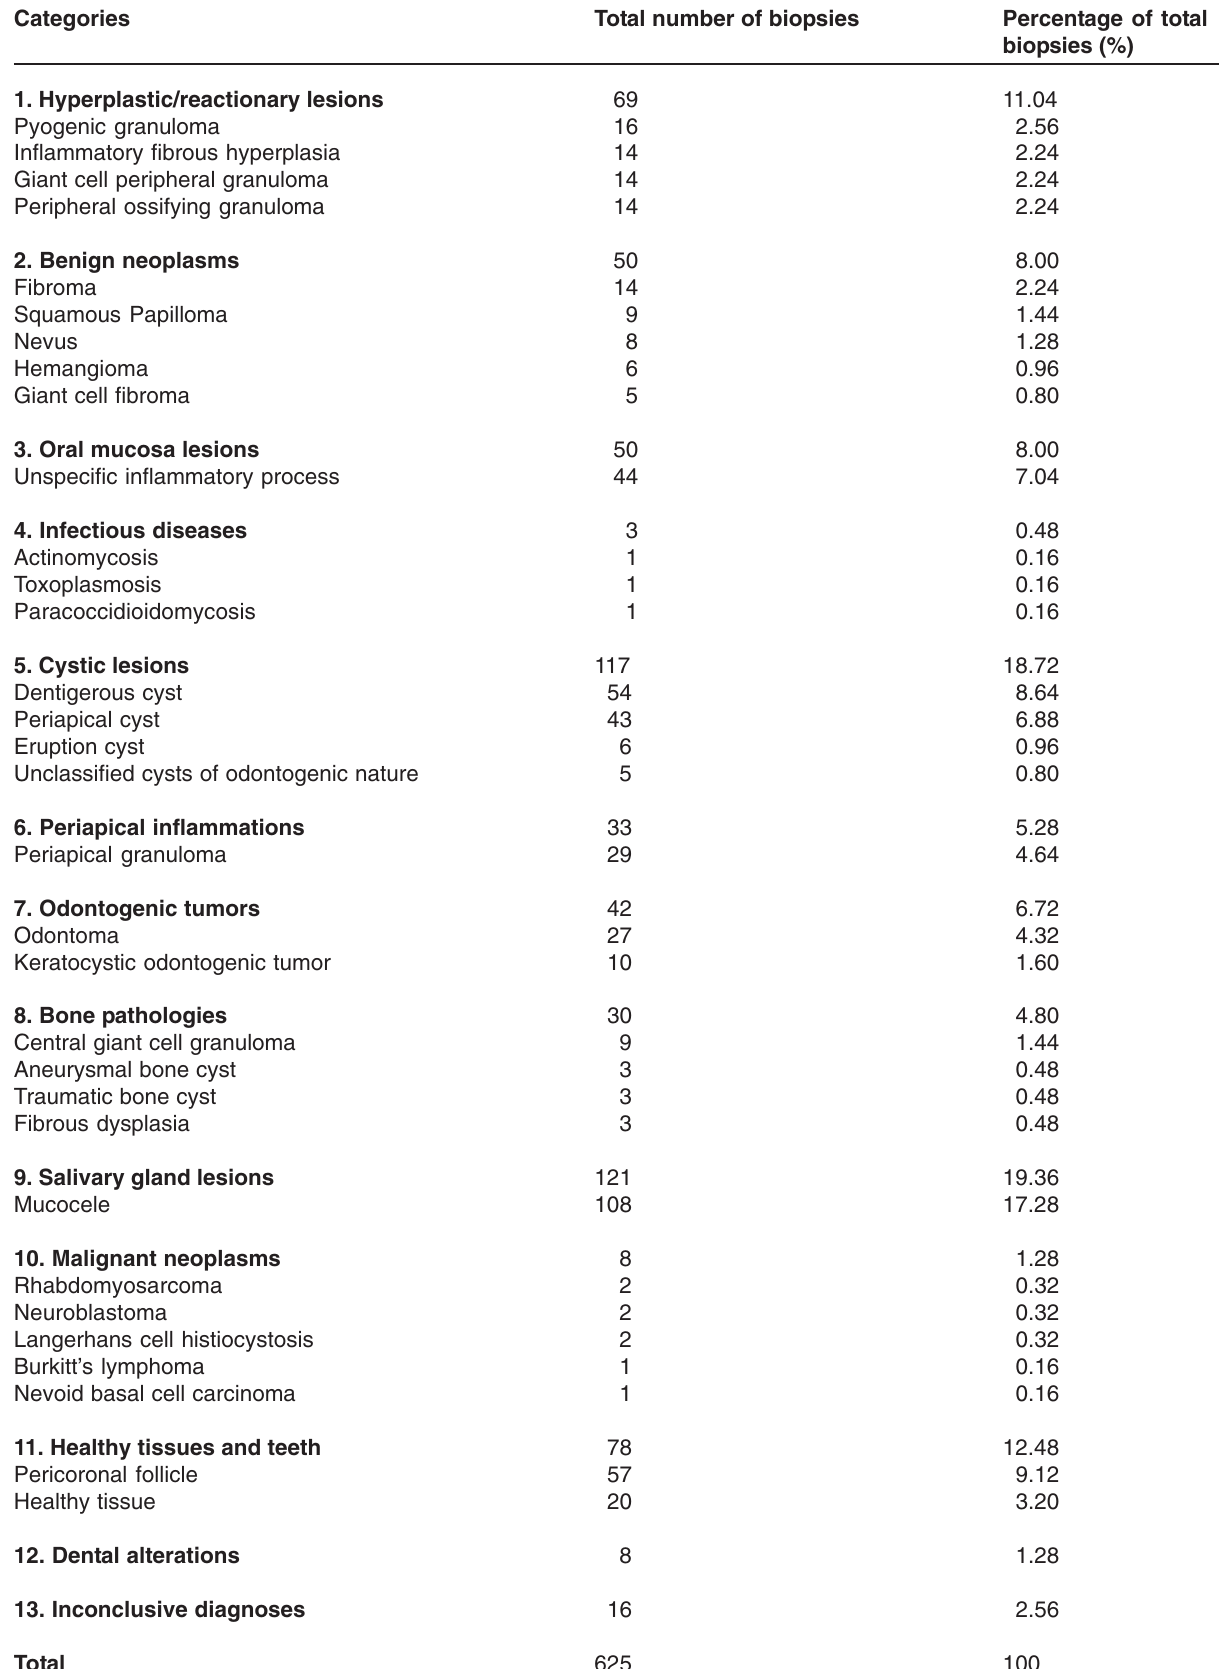
TABLE 1- Distribution of the most common diagnoses in each